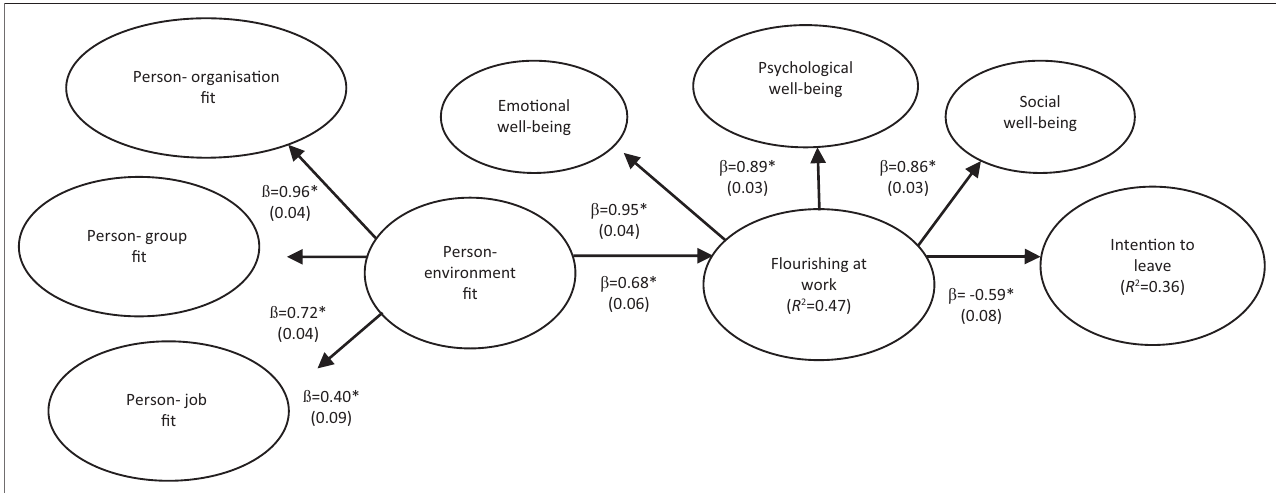
FIGURE 2: The structural model (standardised solution with standard errors in